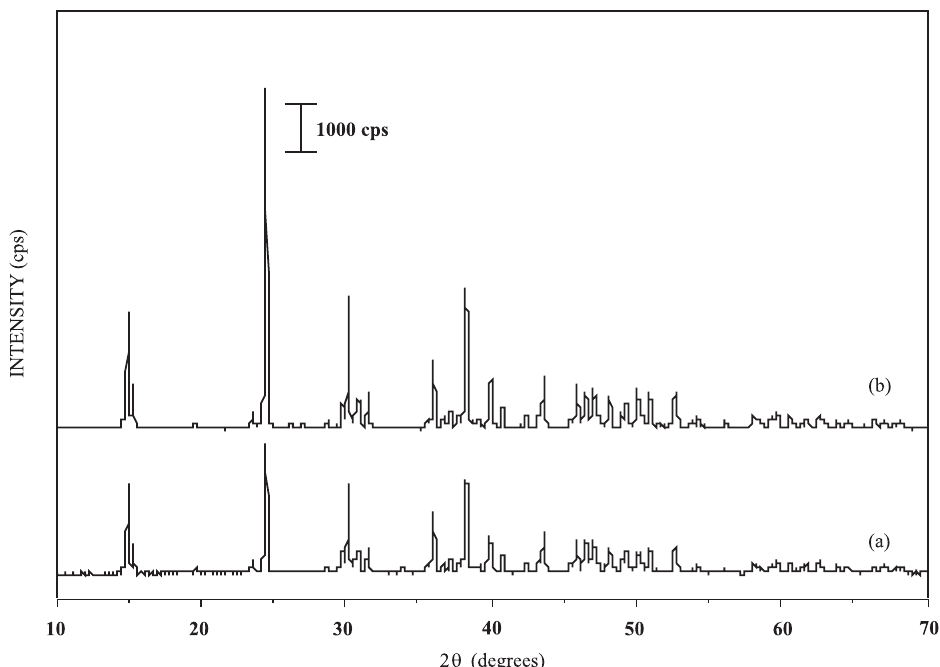
Figure 1. (a) Powder X-ray Diffraction Patterns of (a) synthetic calcium oxalate and (b) biogenic calcium